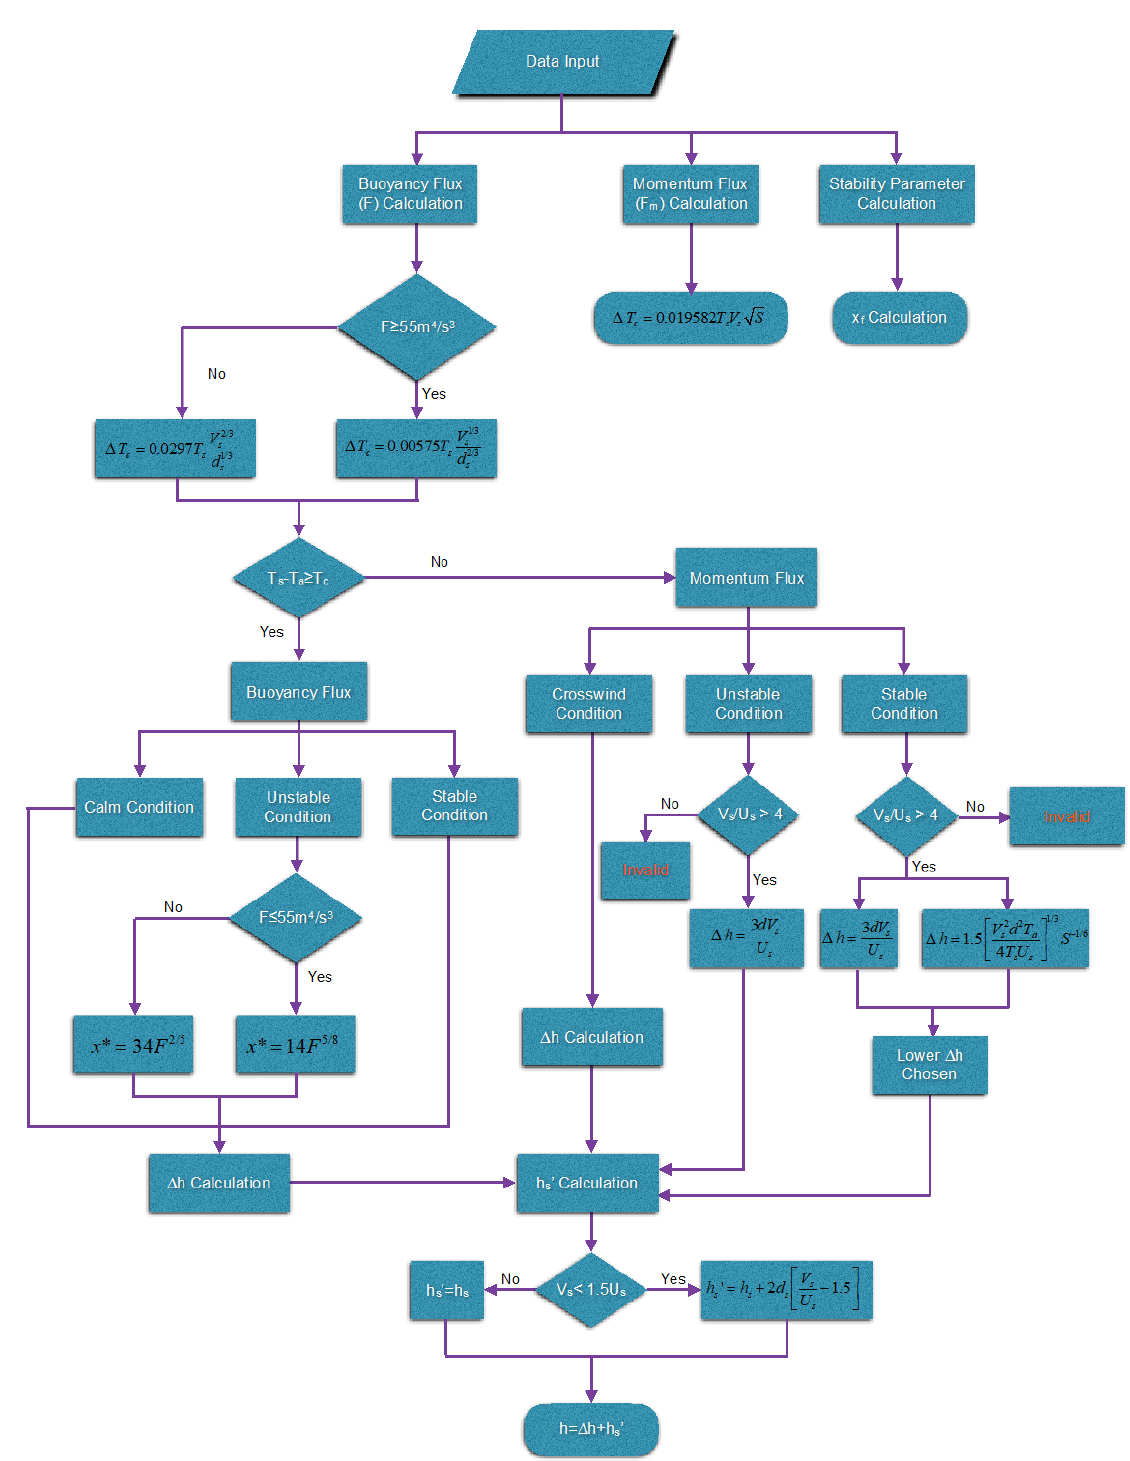
Figure A3. Flow Chart for Detailed Algorithm used in Calculation of Plume Rise Figure 1. ( a ) Drawing of the closed die, ( b ) block sample before forging (50 mm and ( c ) forged plate (82 mm